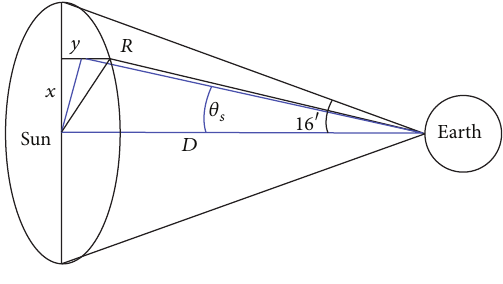
Figure 4: The geometric relationship of Buie model.